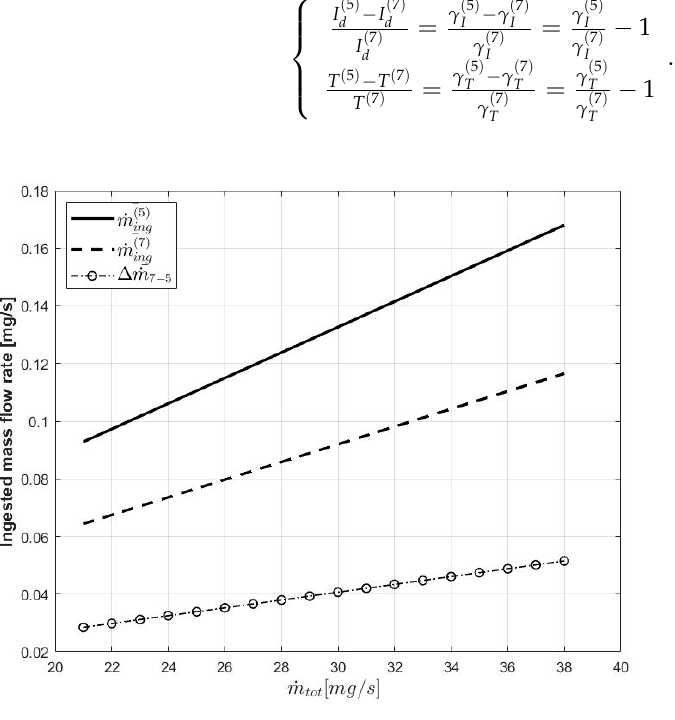
Figure 15. Ingested mass flow rates, computed by the background flow model for the HT20k M and considering 𝛽 = 1.